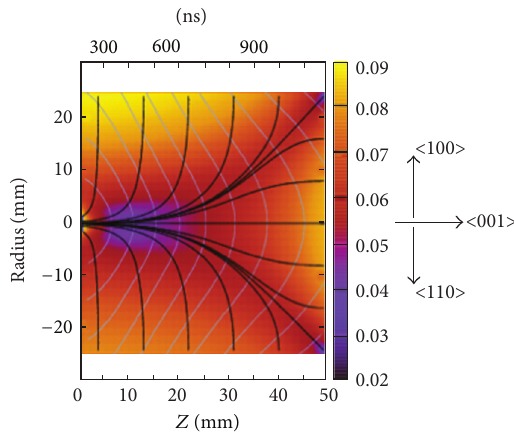
Figure 1: Calculated hole drift in a 5cm diameter × 5cm long P-PC